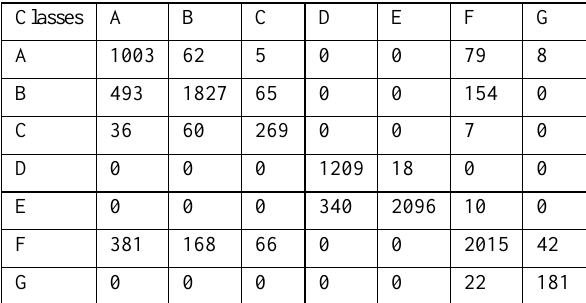
Table 6: Confusion Matrix of